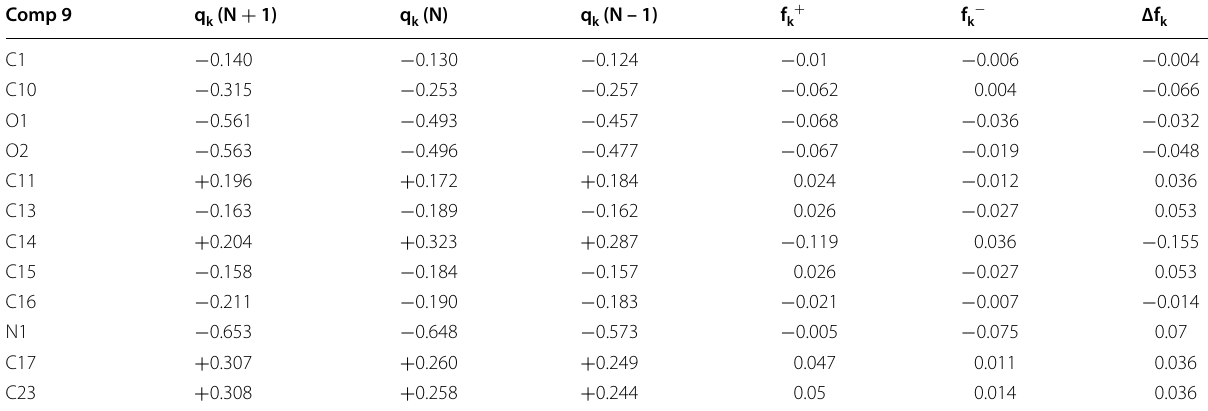
Table 10 Selected Mulliken atomic charges and Fukui functions for Compound 9 Comp